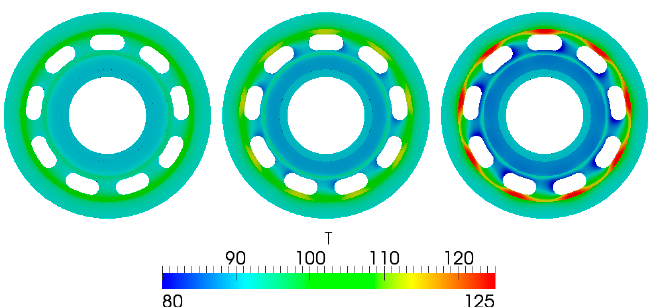
Figure 17. Piston temperature distribution comparison for different sizes.